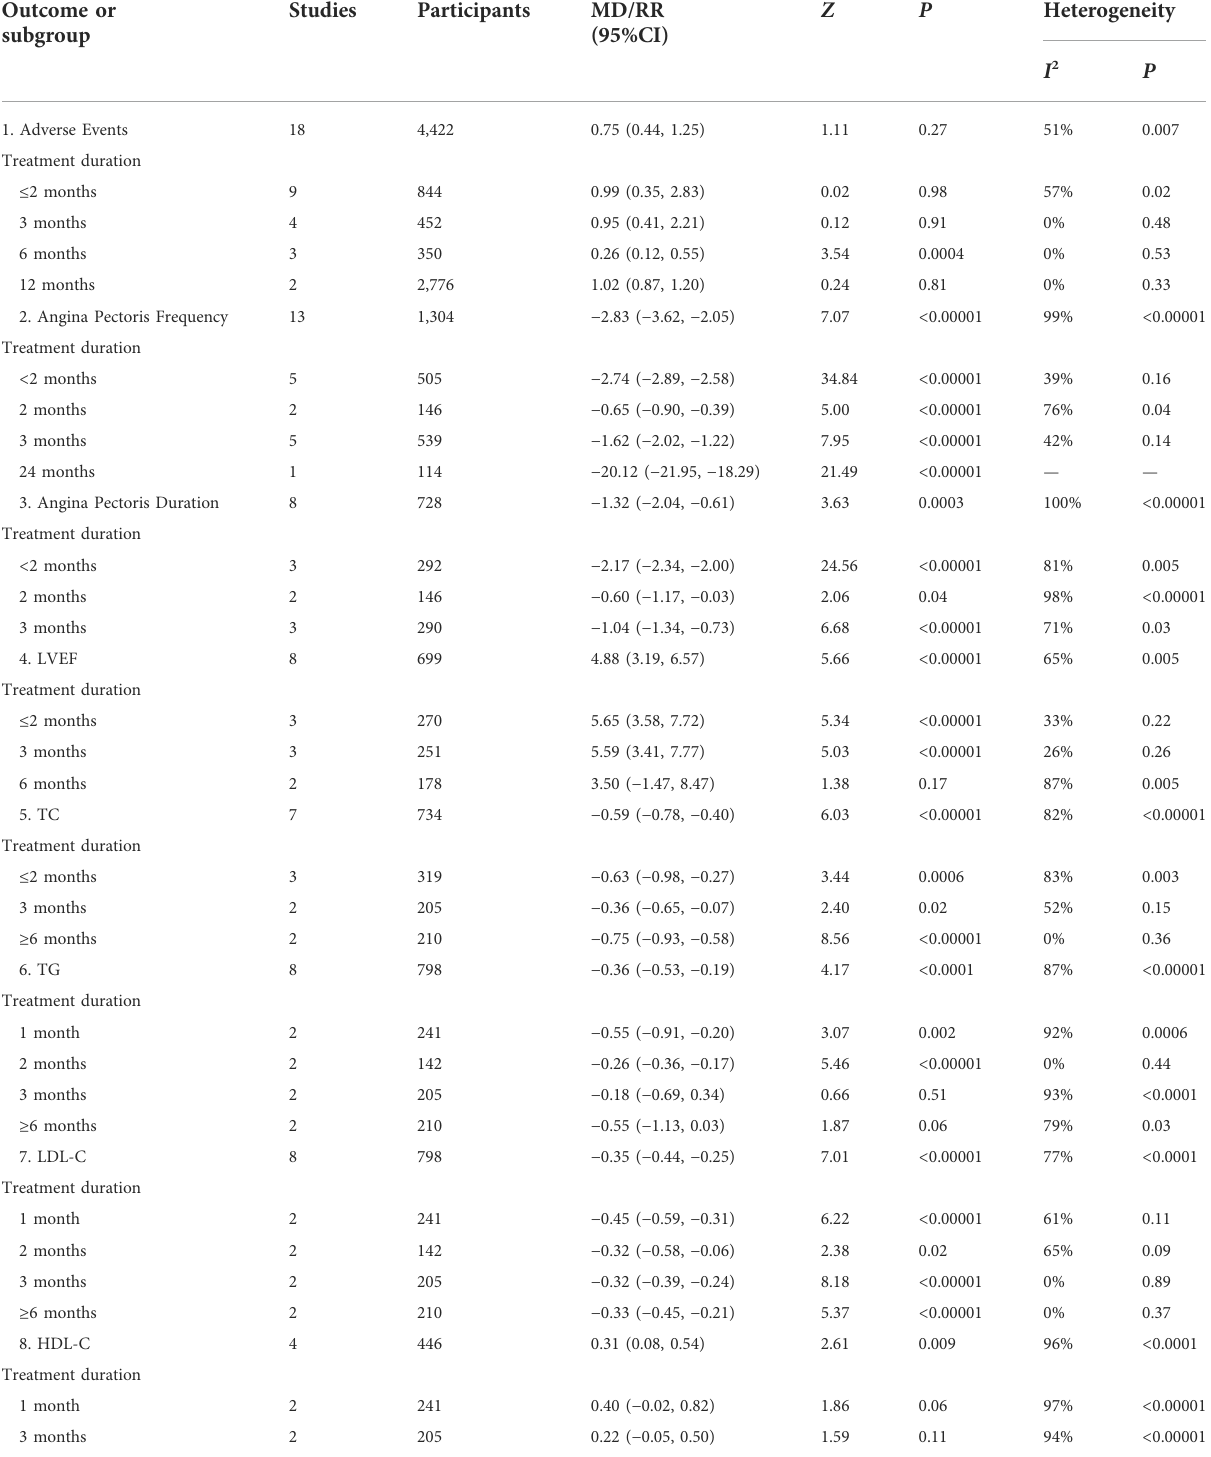
TABLE 2 Results of subgroup